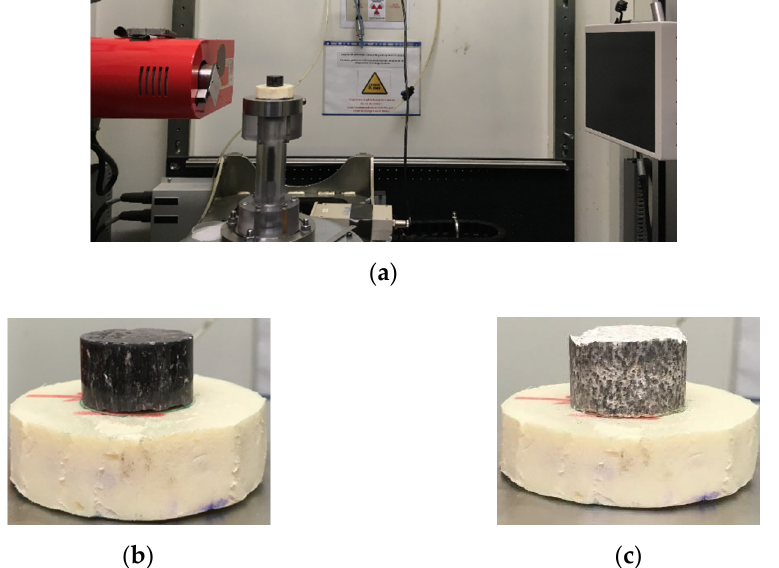
Figure 17. X-ray tomographic system for geotechnical studies: ( a ) The device at Grenoble has a maximum resolution of 5 µm; ( b , c ) calcareous and siliceous sand samples respectively, after compression.